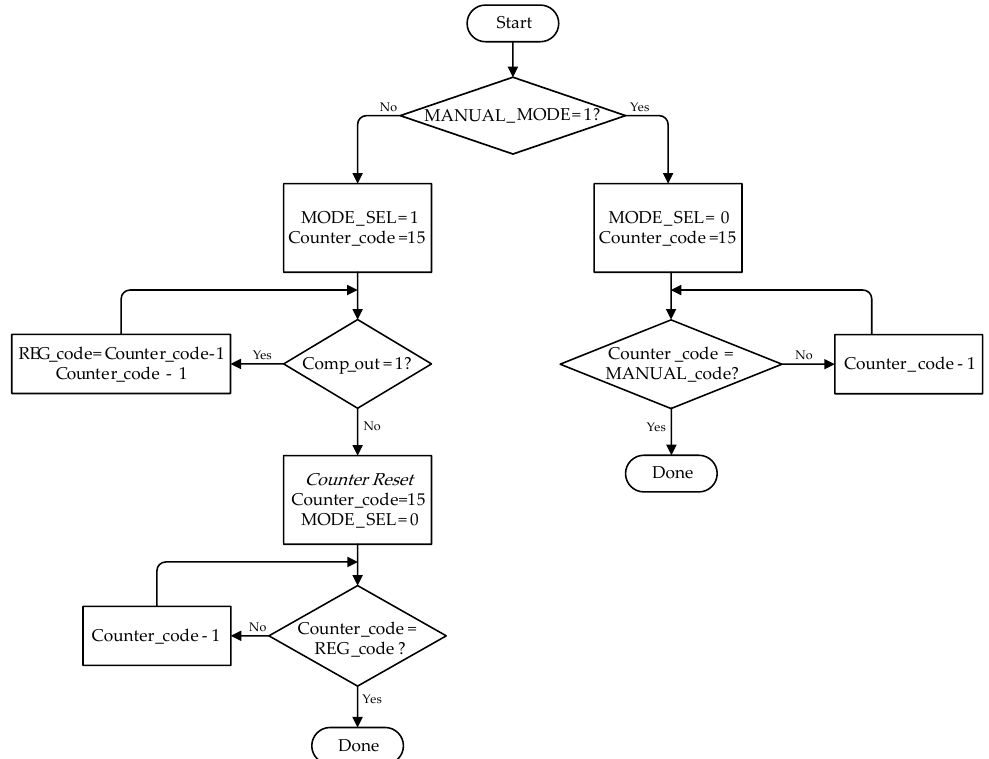
Figure 7. Flow chart of proposed bias calibration